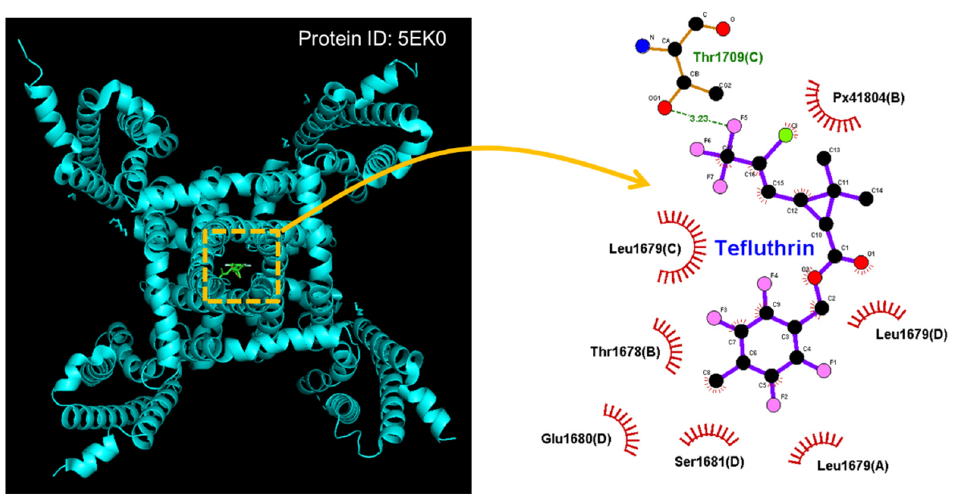
Figure 2. Docking results of the hNa V 1.7 channel and the tefluthrin molecule. The protein structure of hNa V 1.7 was acquired from RCB PDB (ID: 5EK0), whereas the chemical structure of tefluthrin was from PubChem (compound CID: 5281874 [3D conformer]). The structure of the hNa V 1.7 channel was docked by the tefluthrin molecule in PyRx software (http://pyrx.sourceforge.io/) (accessed on 26 July 2022). Diagram of the interaction between the hNa V 1.7 channel and the tefluthrin molecule generated by LigPlot + (http://www.ebi.ac.uk/thornton-srv/software/LIGPLOT/) (accessed on 26 July 2022). Note that the red arcs on which spokes faced radiating toward the ligand (i.e., tefluthrin) represent hydrophobic interactions, while green dotted line residing in amino-acid residue (i.e., Thr1708(C)) is the formation of a hydrogen bond.